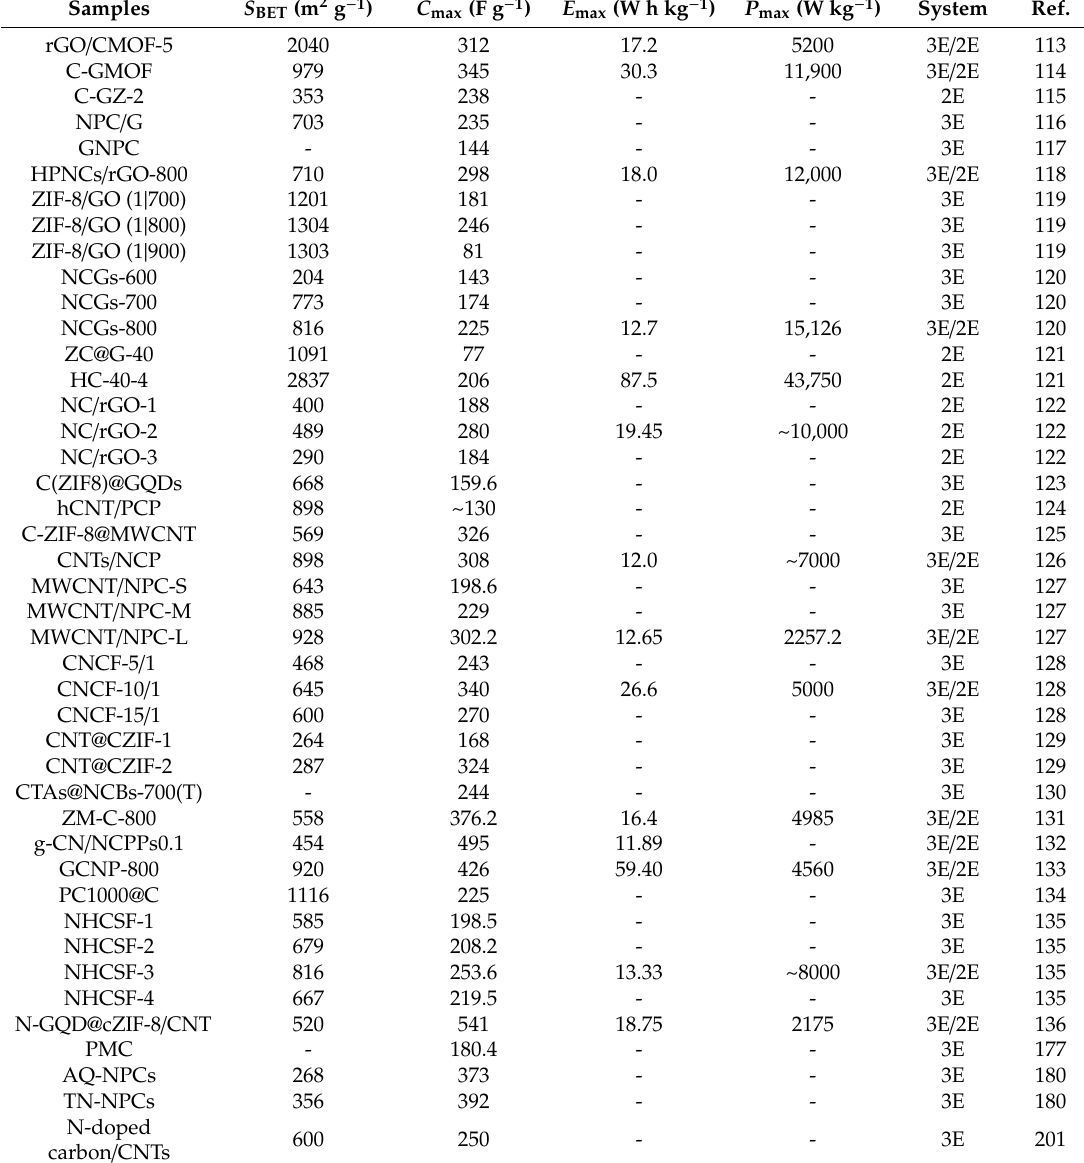
Table 7. The electrochemical capacitive properties of Zn-MOF-derived carbon / carbon composites.